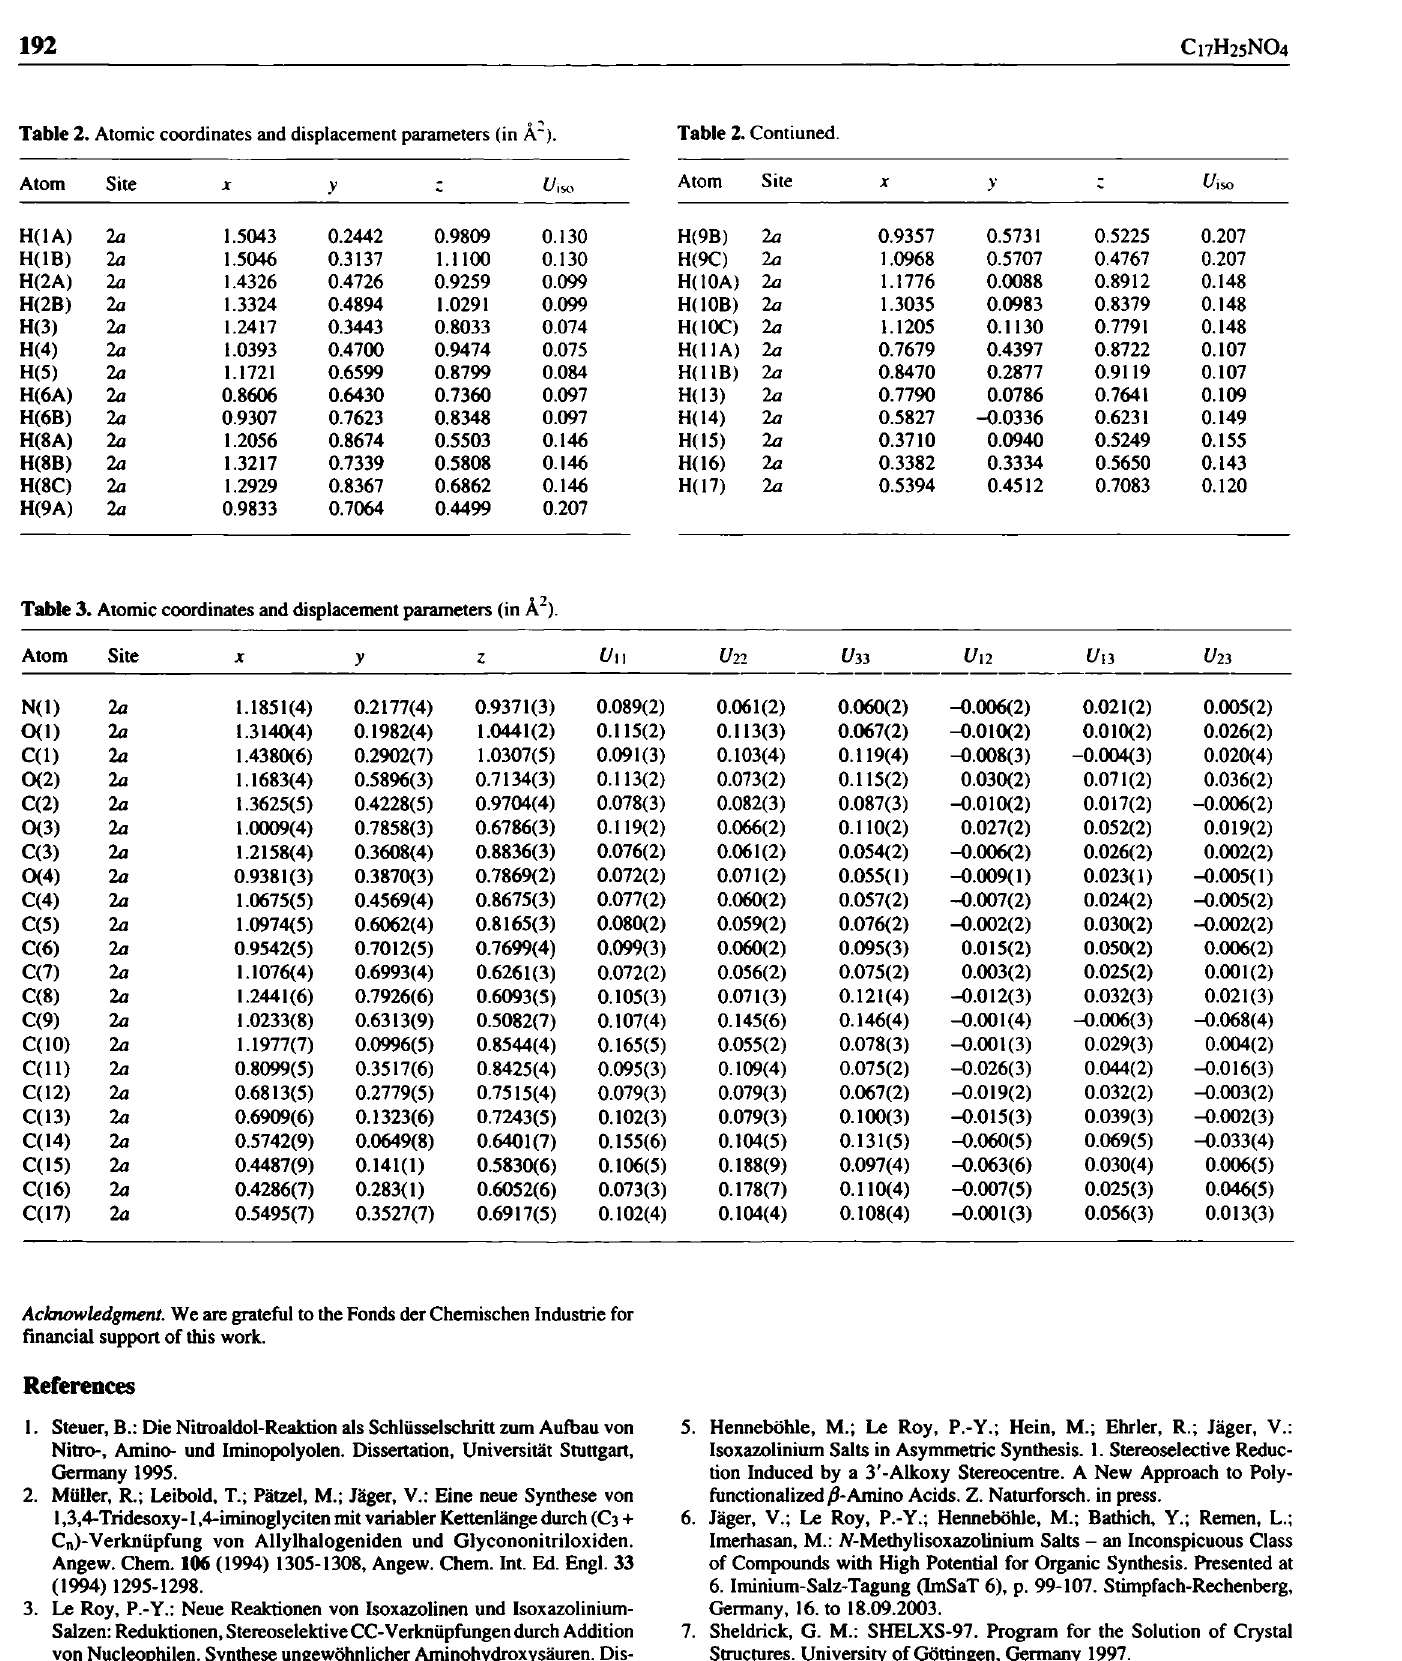
Table 2. Atomic coordinates and displacement parameters (in À"). Table 2. Contiuned.